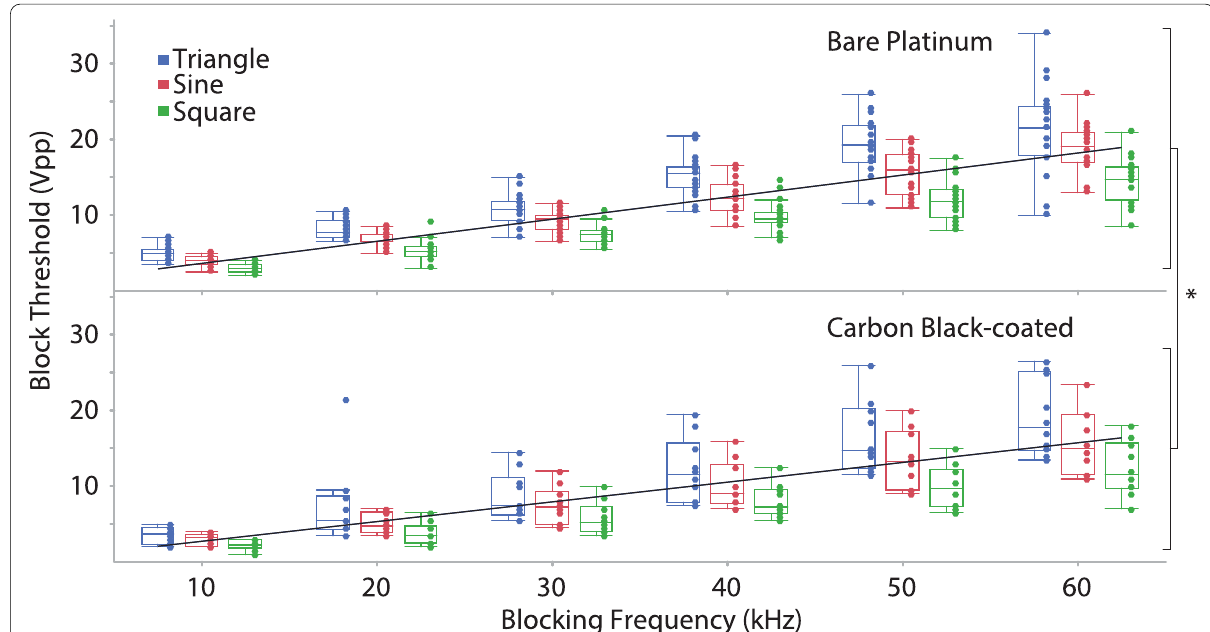
Fig. 6 Block thresholds versus frequency for both electrode types. For all waveform shapes, BT increased linearly versus frequency (regression equations for bar platinum and carbon black-coated electrodes, respectively: 0.29*frequency